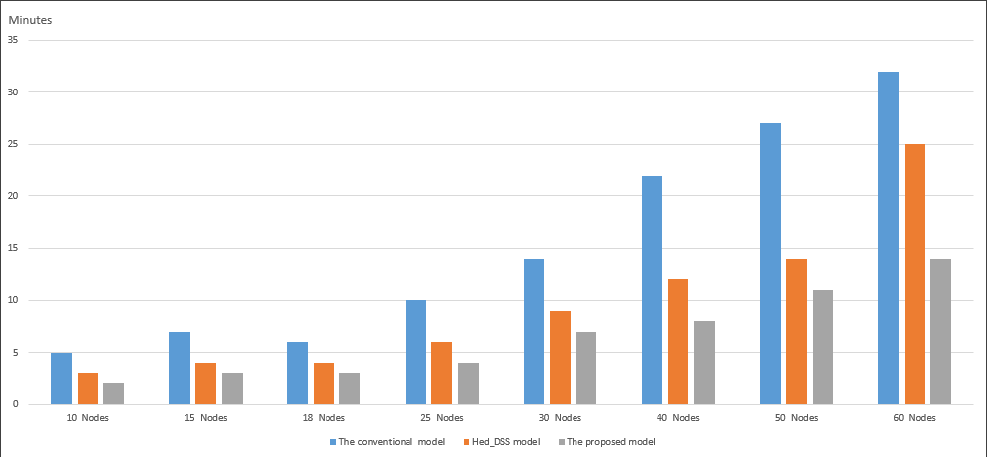
Figure 14. Evaluation of time in 5 decision-making objects with a variety of